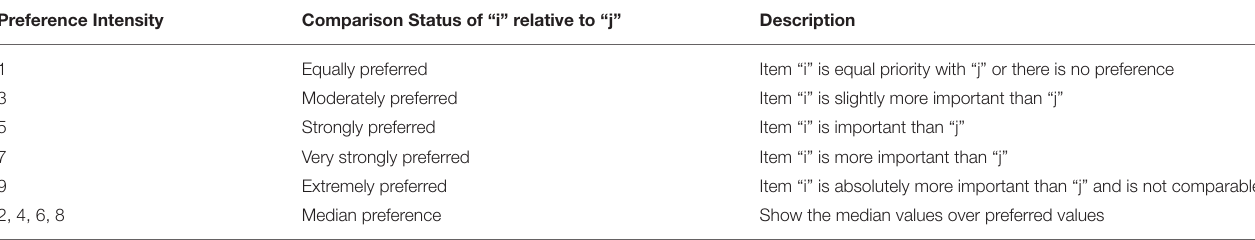
TABLE 1 | Preference intensity evaluation by binary comparison relatively between criteria in AHP (Ghodsipour, 2003; Rezaei and Tahsili, 2018).